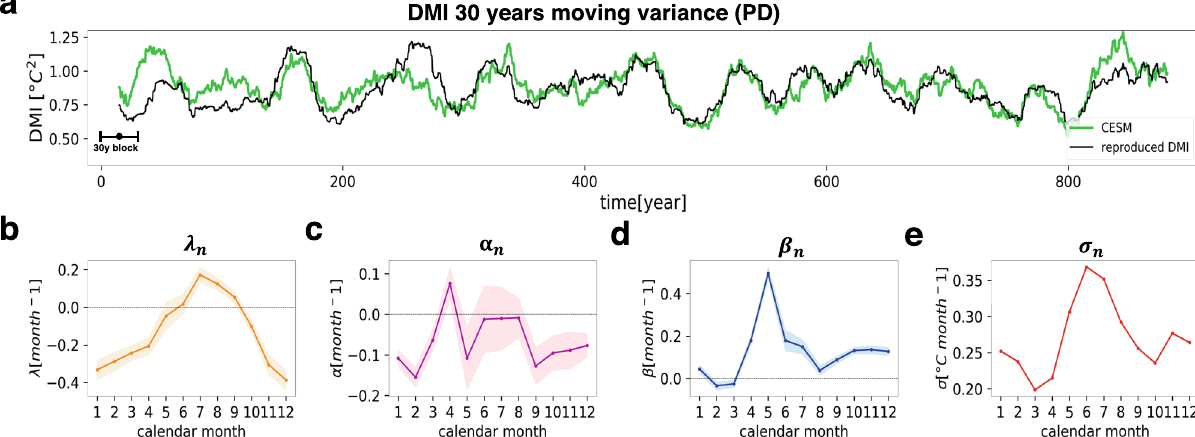
Fig. 2 Reproduced DMI by simple IOD model and corresponding parameters. a Timeseries of 30-year moving variance of DMI anomaly for the present-day simulations obtained by the original CESM1.2 (green contour) and the simple IOD model (black contour). Units are °C 2 . b Climatological values of parameter λ n for the simple IOD model obtained using the present-day simulation of CESM1.2. c – e are the same as b except for α n , β n , and σ n , respectively. Units for parameters are (month) − 1 . Light colored thick lines in b – e indicate the ensemble